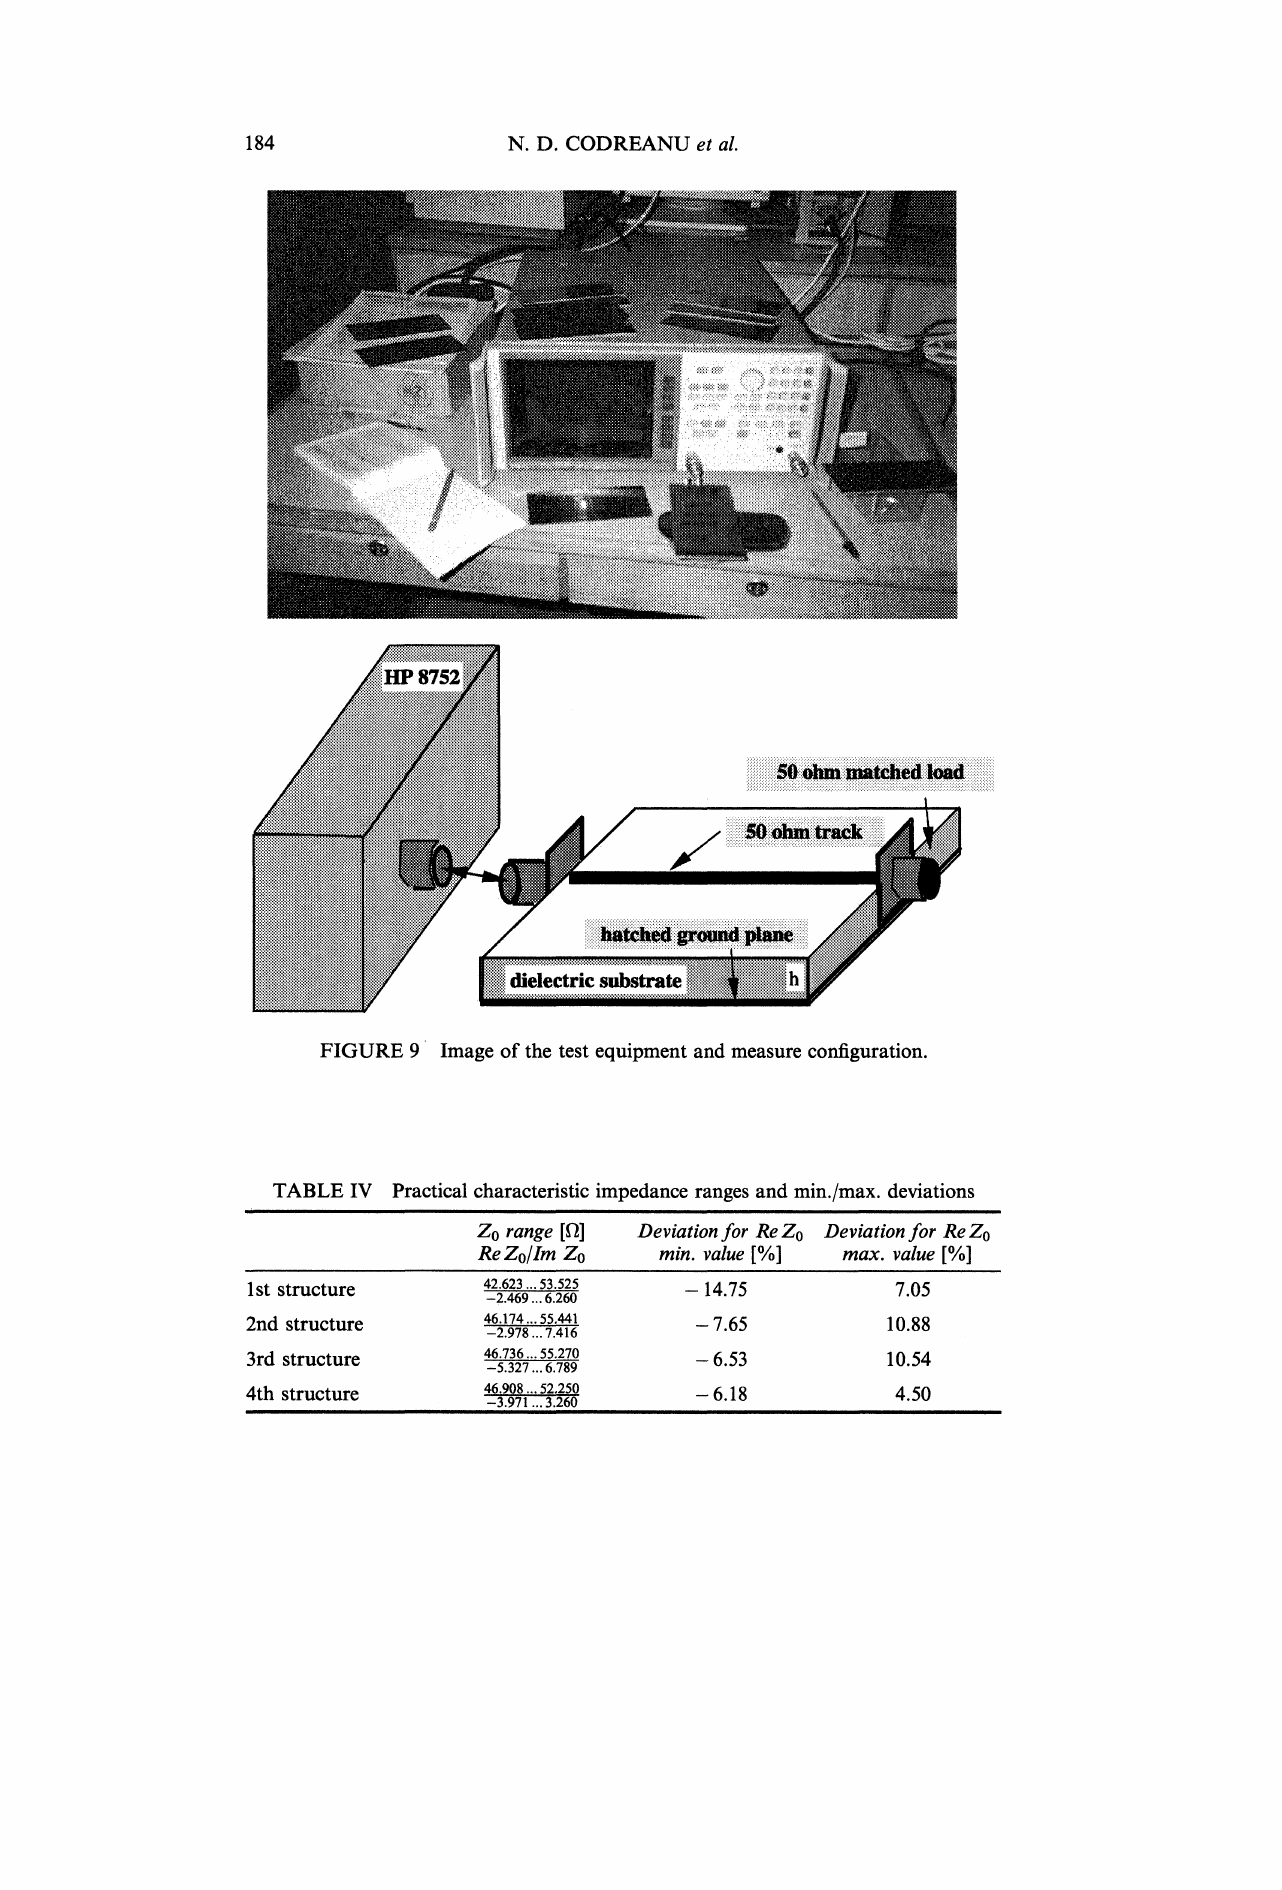
FIGURE 9 Image of the test equipment and measure configuration.